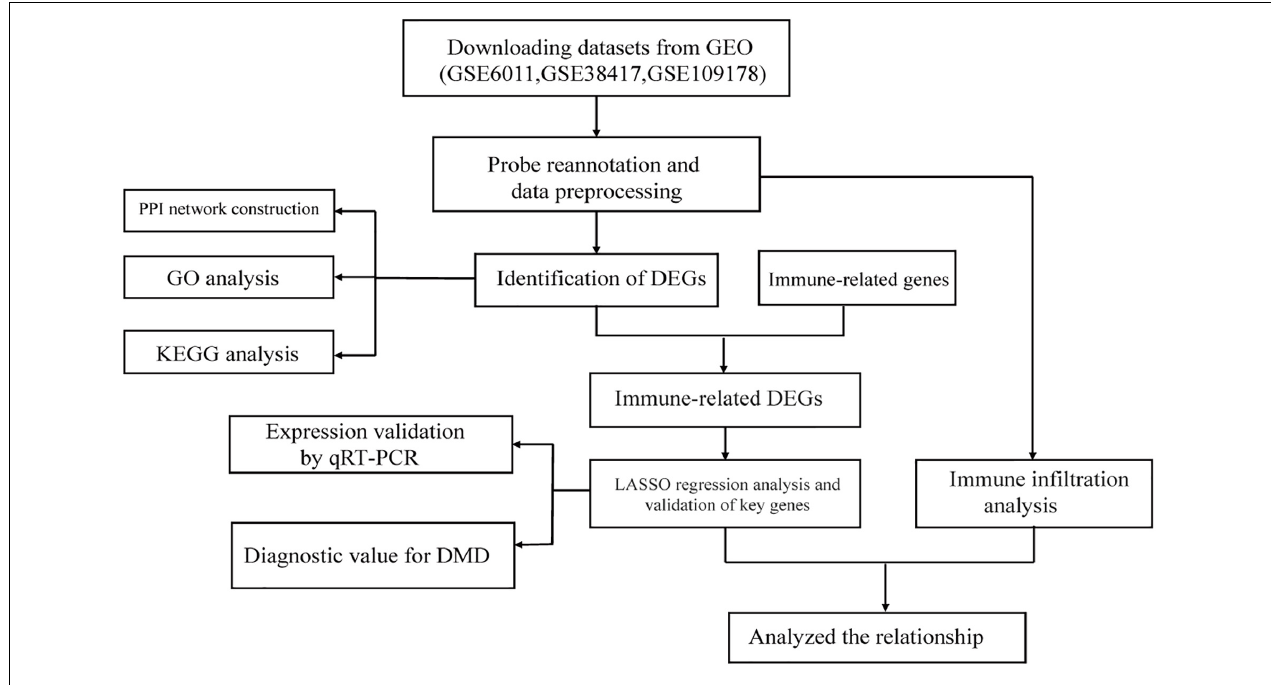
FIGURE 1 | Schematic illustration of the workflow involved in this study.